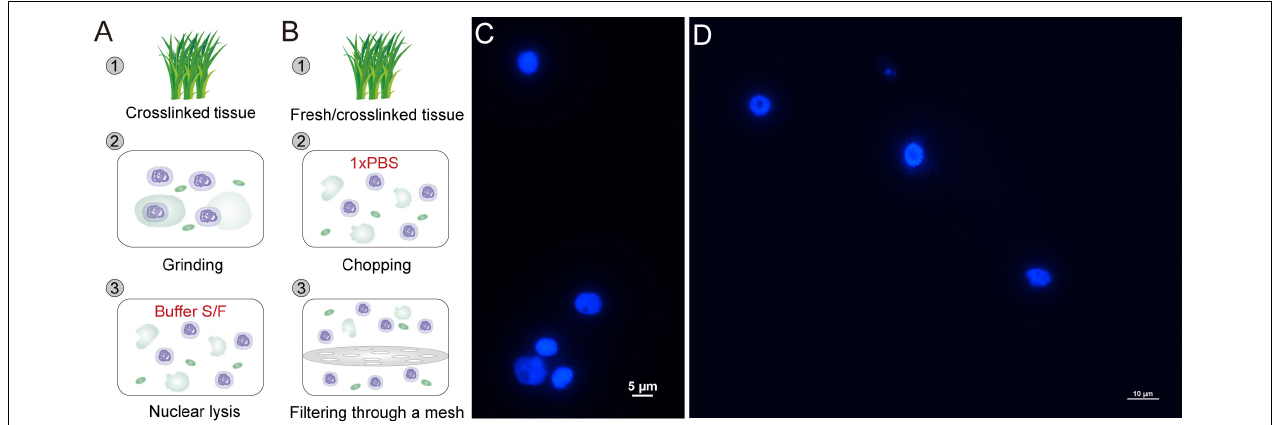
FIGURE 1 | Rapid and efficient isolation of high-integrity nuclei. (A,B) Two strategies for nuclei isolation with crosslinked or fresh tissue. Crosslinked tissue is ground to fine powder and lyzed with Buffer S and Buffer F (A) . Crosslinked or fresh tissue is chopped to homogenate lysates in PBS and filtered through a mesh (B) . The released nuclei are collected by centrifugation. The nuclei isolated with Buffer S/F (C) or PBS (D) are stained with DAPI and observed under a fluorescence